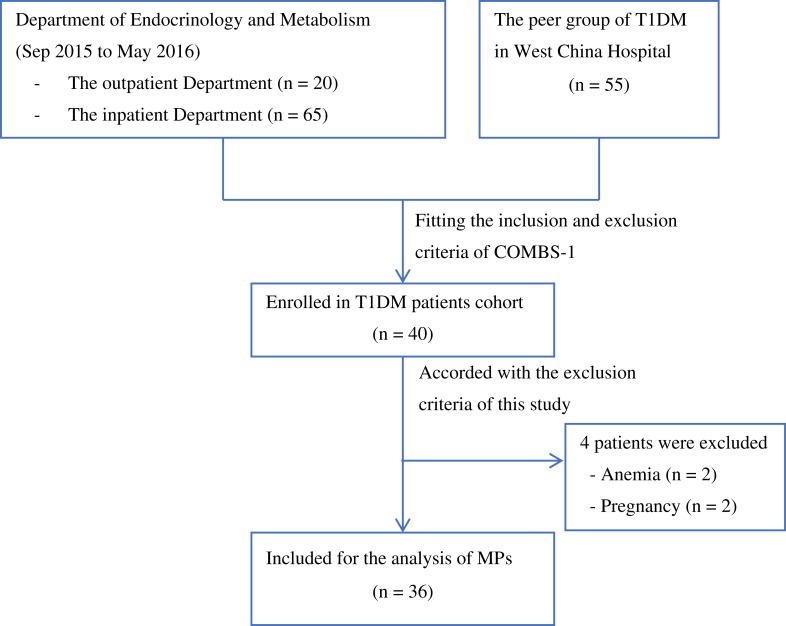
Flowchart of T1DM patient enrollment.